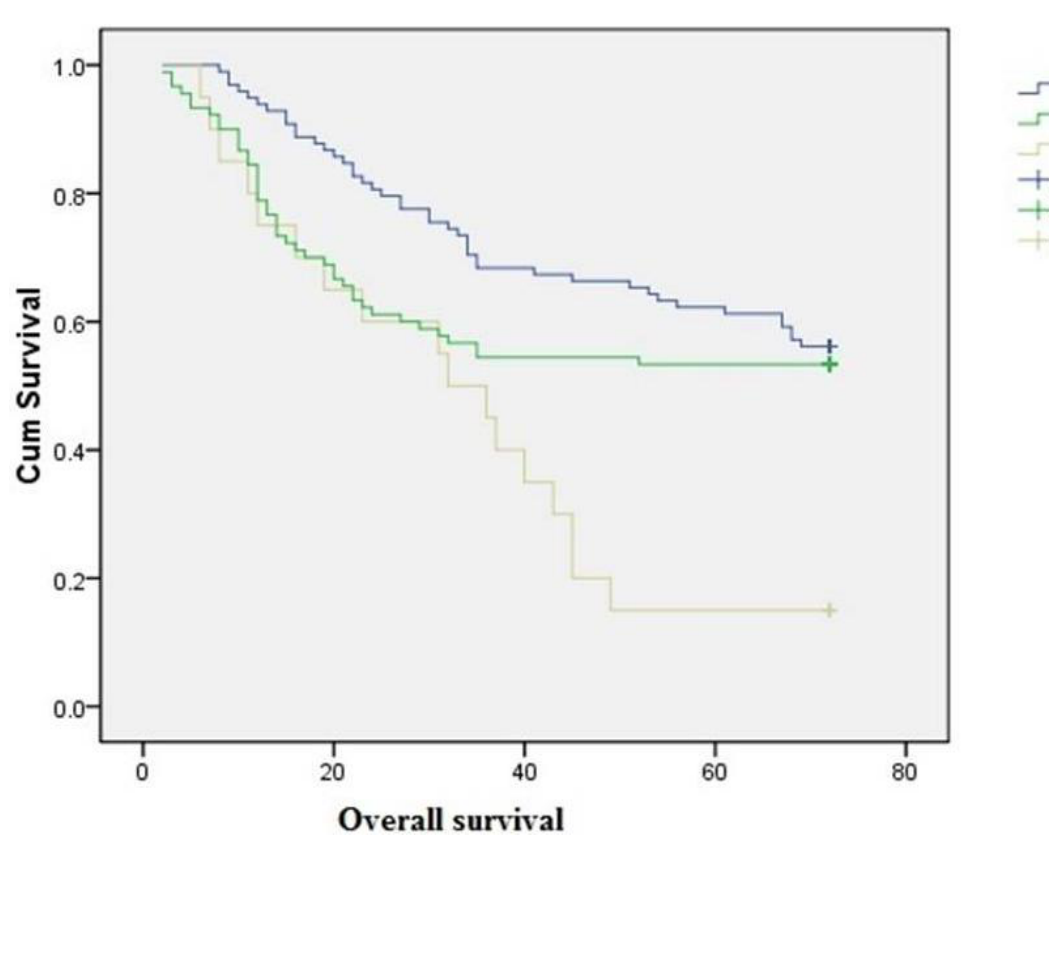
Figure 1. Overall ovarian cancer survival by MTHFR gene